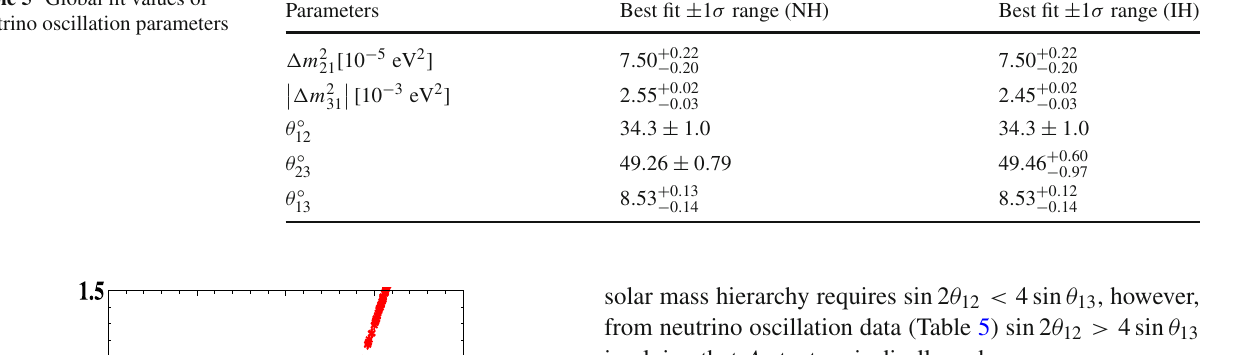
Table 5 Global fit values of neutrino oscillation parameters